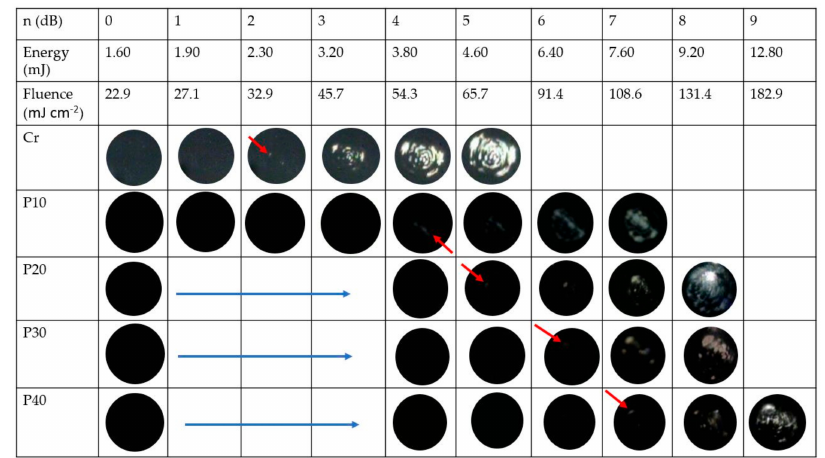
Figure 7. Photographs depicting the film surface of photoacoustic transmitters after pulsed laser irradiation. A given laser energy and fluence are shown in the first and second row, respectively. The red arrows indicate the starting point where ablated spots are firstly shown in each